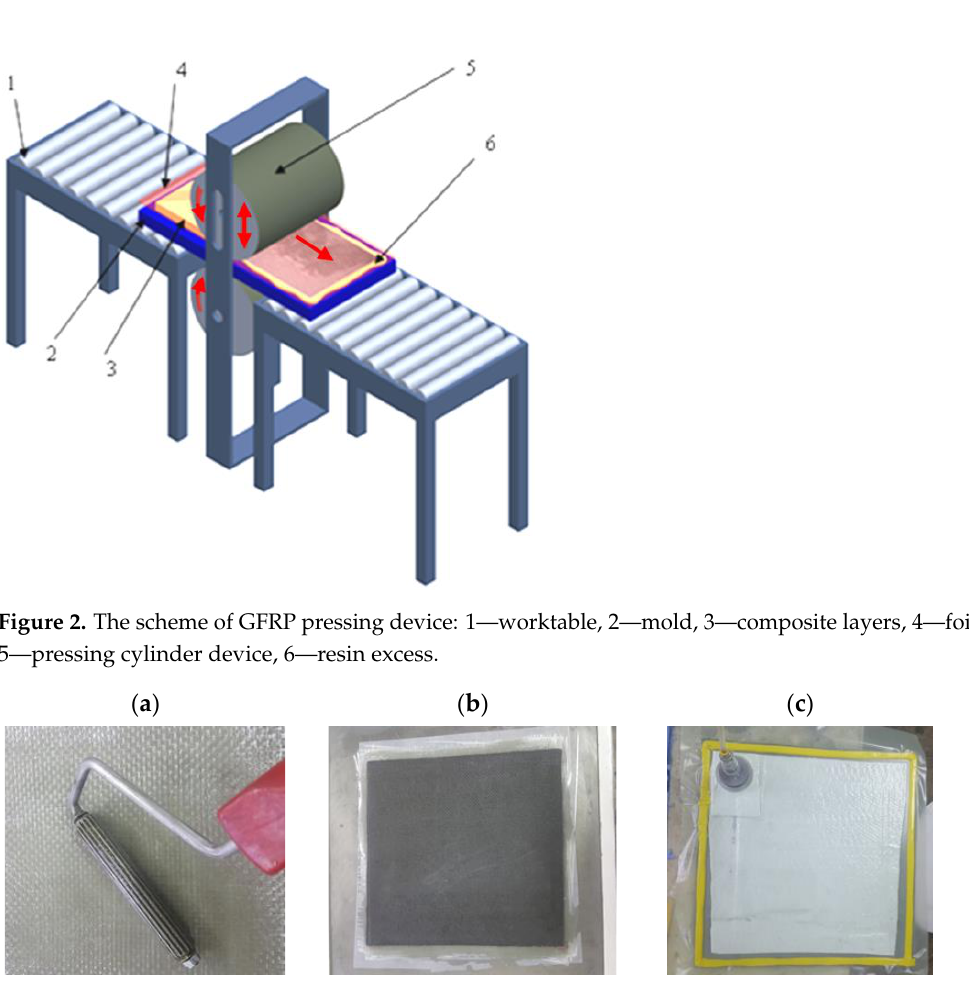
Figure 3. Vacuum bag technology applied for B2 GFRP